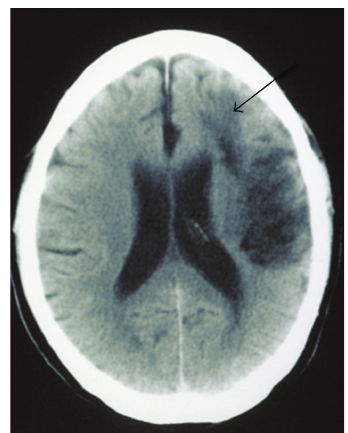
Figure 1: Axial Computed tomography of the brain demonstrated cortical infarction in the left frontal lobe.